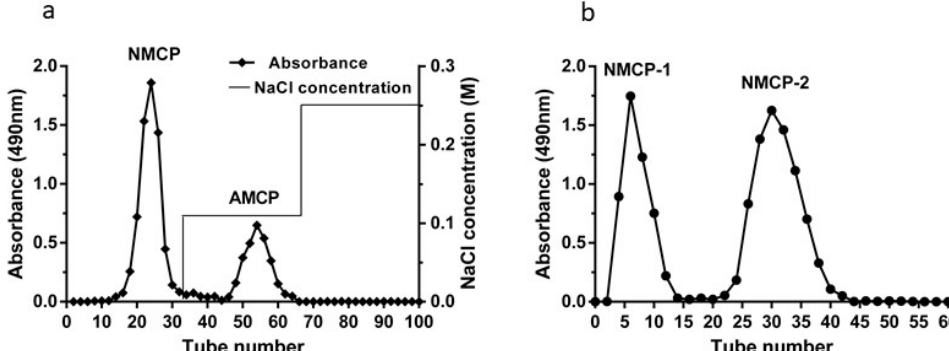
Figure 1. The elution curve of polysaccharides isolated from the M. conica on a DEAE-52 cellulose column. ( a ) The DEAE-52 cellulose column was eluted with a 0–0.25 mol/L linear gradient of NaCl at a flow rate of 1 mL/min. The polysaccharide fractions were pooled and named as neutral M. conica polysaccharides (NMCP) and AMCP, respectively. ( b ) Elution curve of the NMCP on a Sephadex G-100 column. The Sephadex G-100 column was eluted with distilled water at a flow rate of 0.3 mL/min. The two polysaccharide fractions were named NMCP-1 and NMCP-2, respectively.